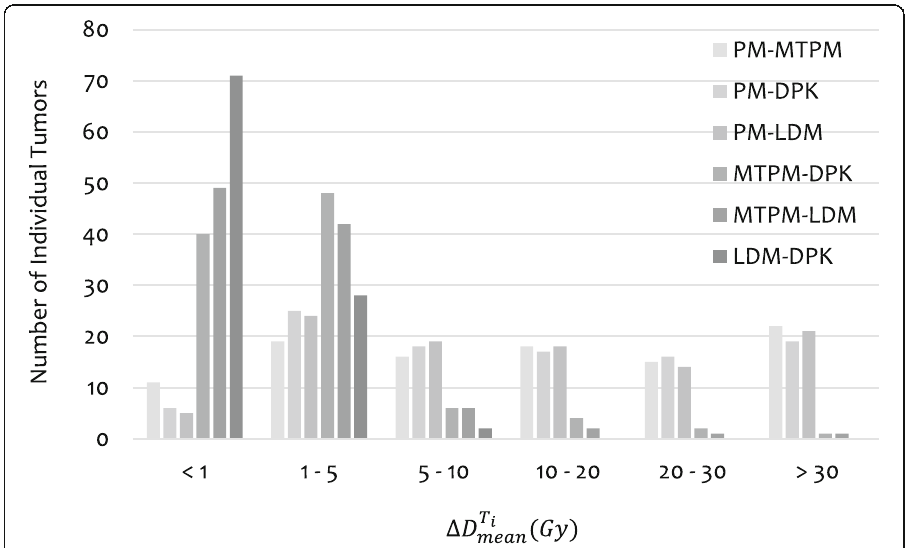
Fig. 7 Distribution of differences in mean dose absorbed within individual tumors for the studied methods compared by